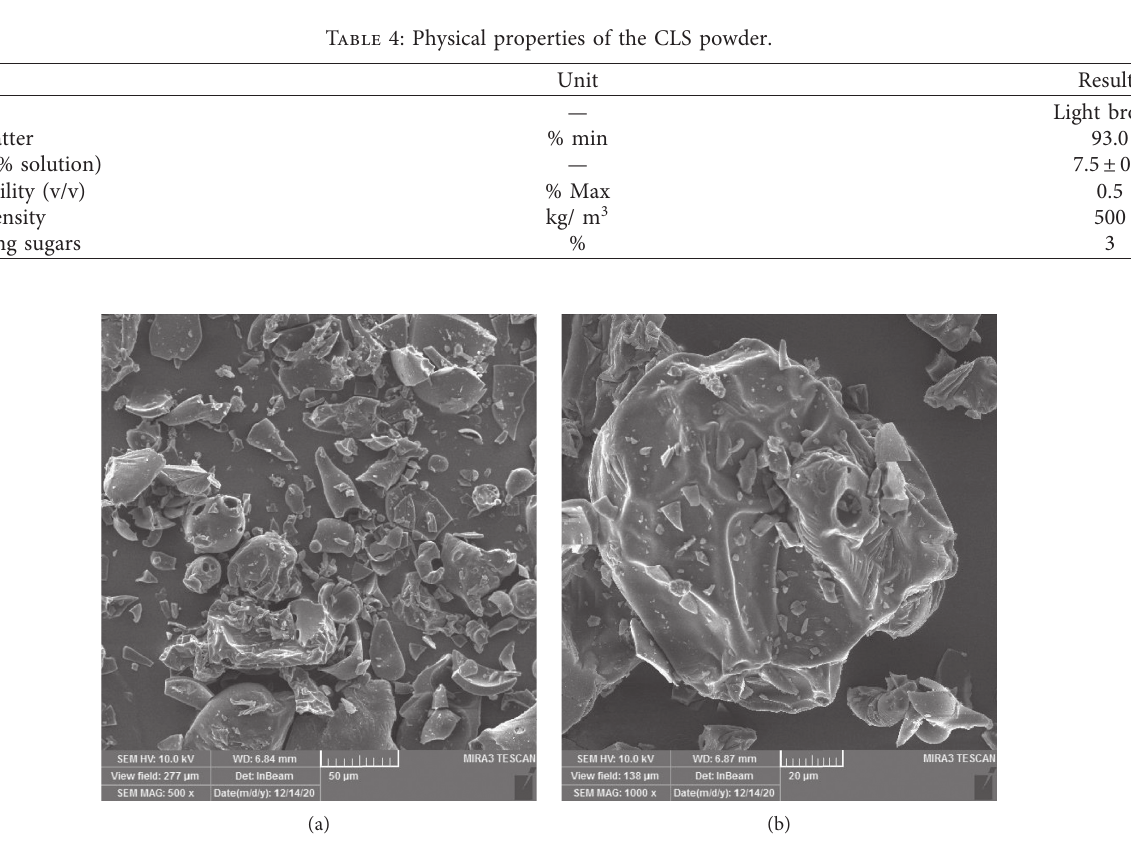
Figure 2: The FESEM images of CLS powder taken at (a) 500x zoom and (b) 1000x zoom. Table 5: Elemental analysis of CLS powder by EDX.